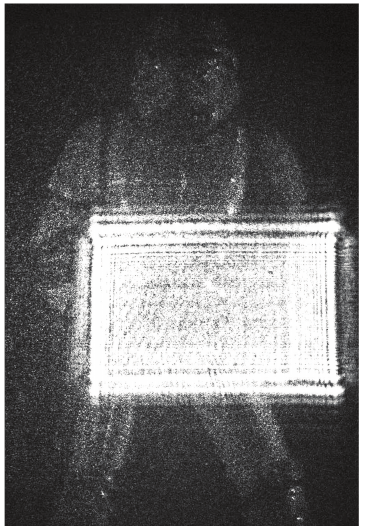
Figure 14: Optical reconstruction of holographic data with SLM: reconstruction of intensity